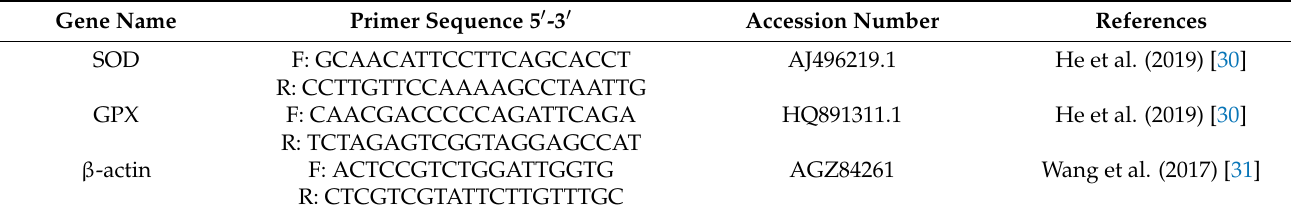
Table 2. The primer pairs used in this